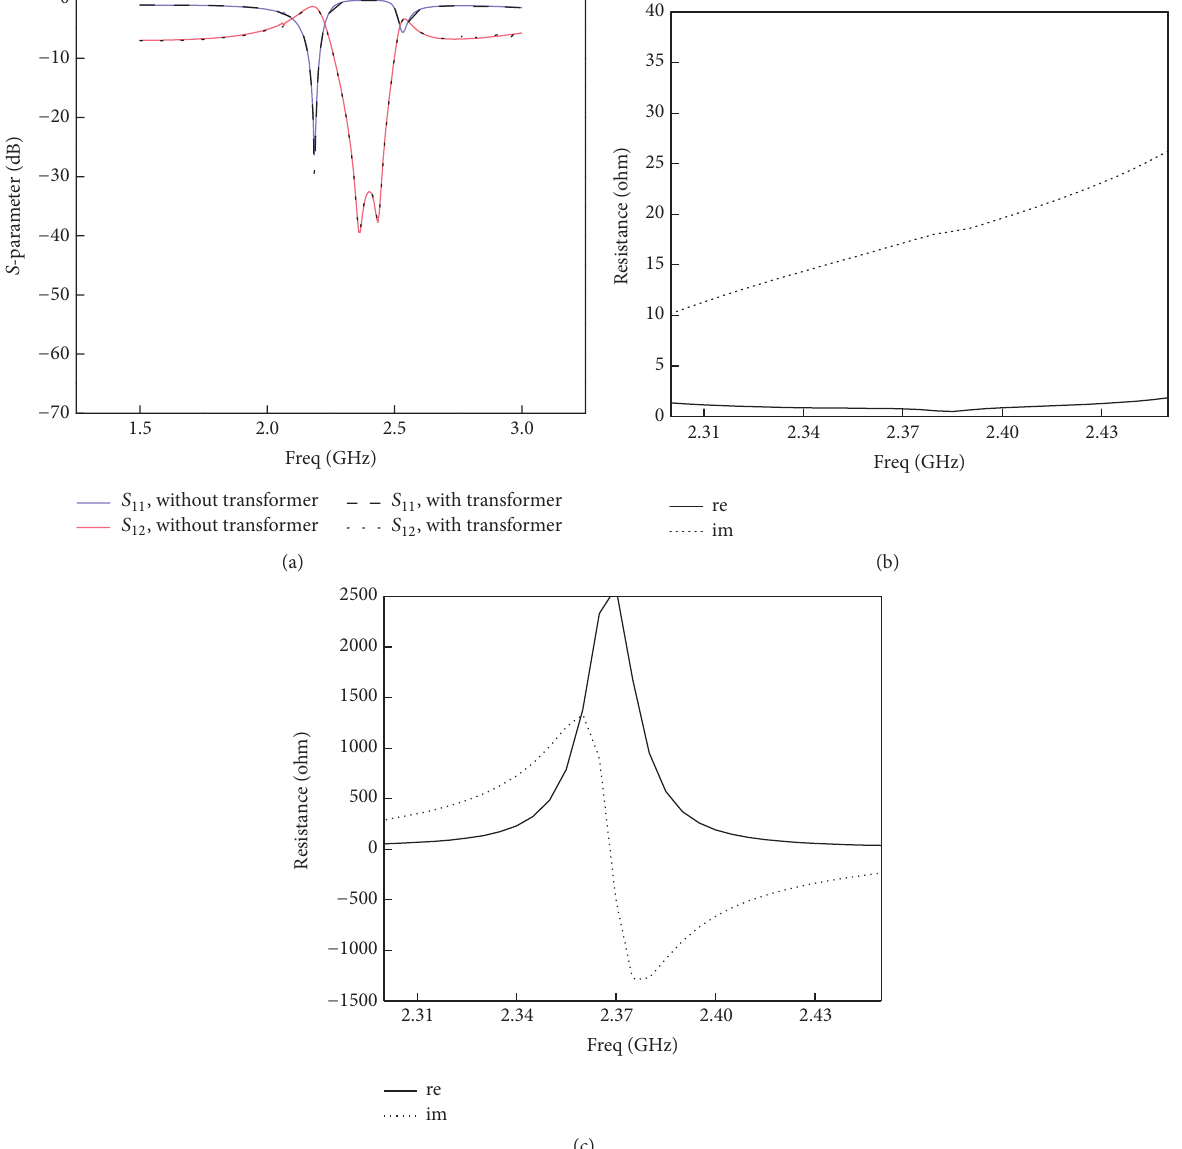
Figure 4: Simulated 𝑆 -parameter and input impedance of Tx BSF: (a) 𝑆 -parameter of the BSFs with and without transformer, (b) input impedance 𝑍 in of the BSF without transformer, (c) input impedance 𝑍 in of the BSF with transformer ( 𝑍 1 = 100 Ω , 𝑍 2 = 10 Ω , 𝜃 2 = 𝜋/2 , = 𝜋/2, Δ𝜃 = 𝜃 /50 𝜃 2 2